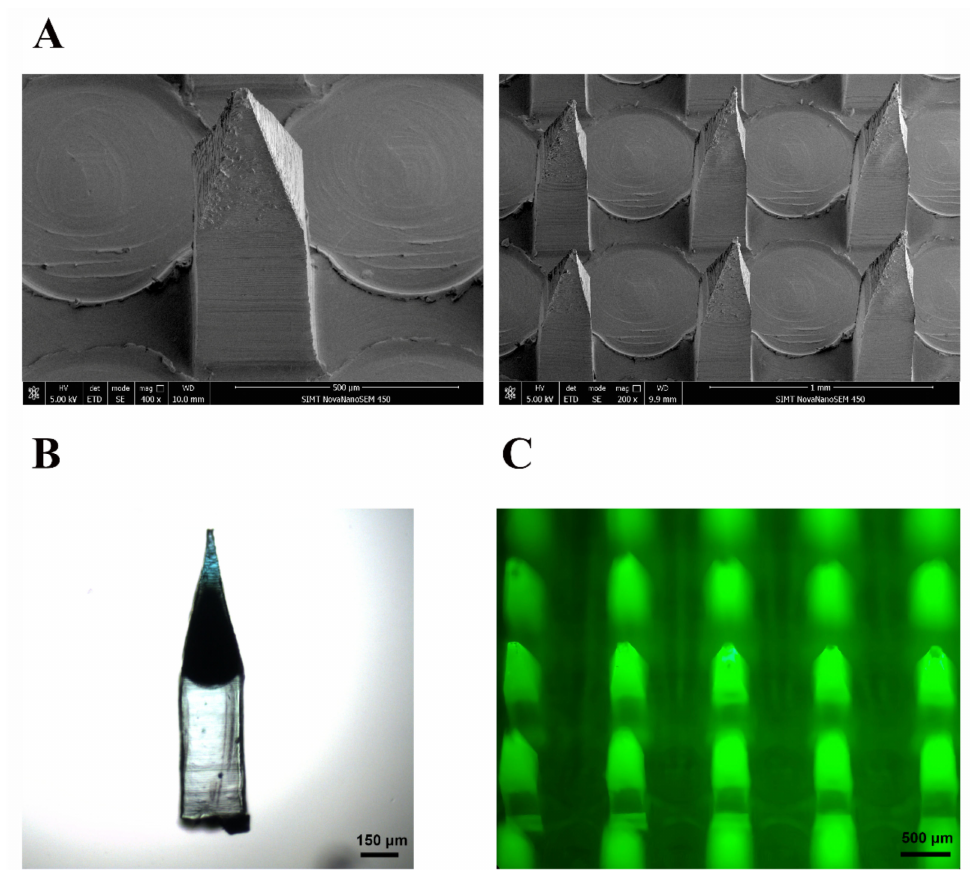
Figure 2. Characterization of the microneedles. ( A ) Scanning electron microscopy images show the morphology of the microneedles. ( B ) Drug distribution in the tip of the needle was illustrated by methylene blue. ( C ) Fluorescence images of the microneedles with FITC as a tracer